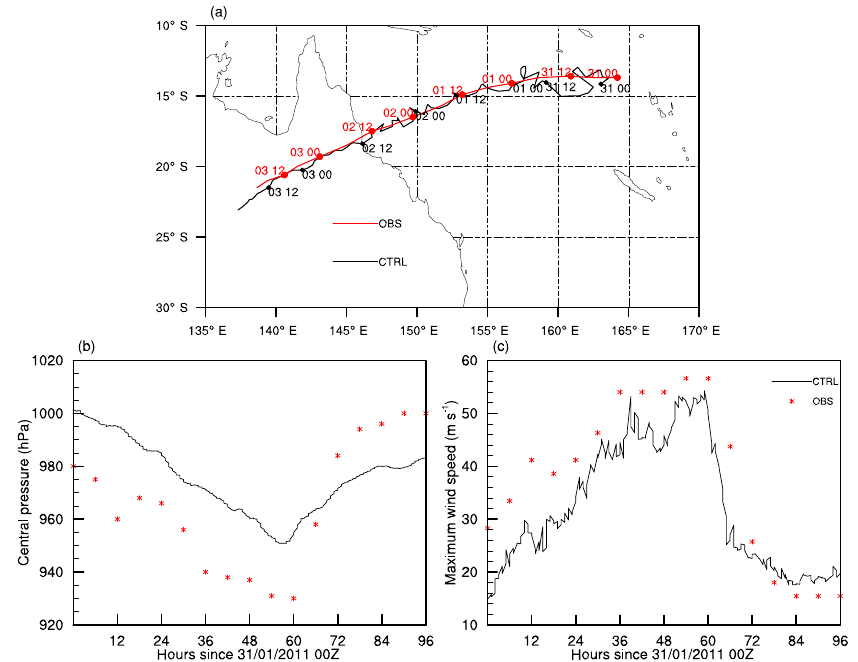
Figure 1. (a) Simulated (black) and IBTrACS observed (red) track of TC Yasi. Time is indicated. (b) Minimum pressure (hPa) and (c) Max- imum wind speed (ms − 1 ) of modelled CTRL simulation of TC Yasi (black line) and observations from IBTrACS (red